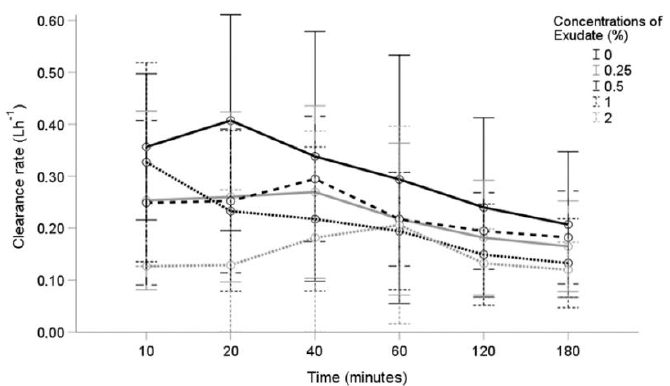
Figure 6. M. galloprovincialis clearance rates (Lh −1 ) exposed to different A. armata exudate concentrations over time.